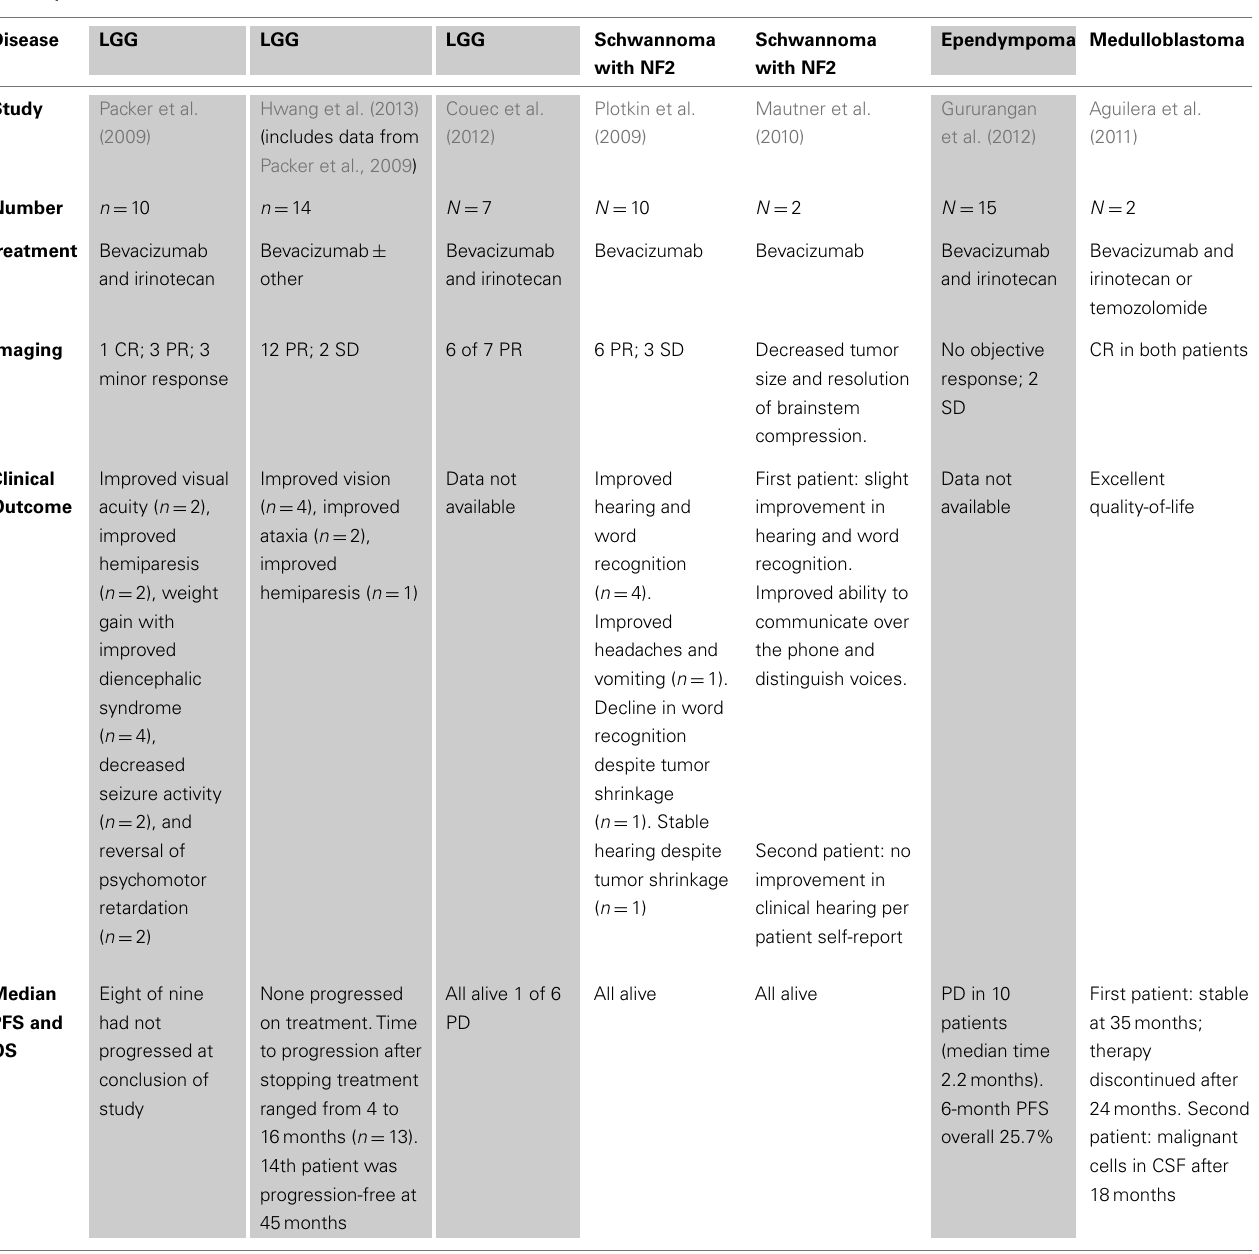
Table 2 | Efficacy results for low-grade glioma, NF2, and other CNS malignancies.